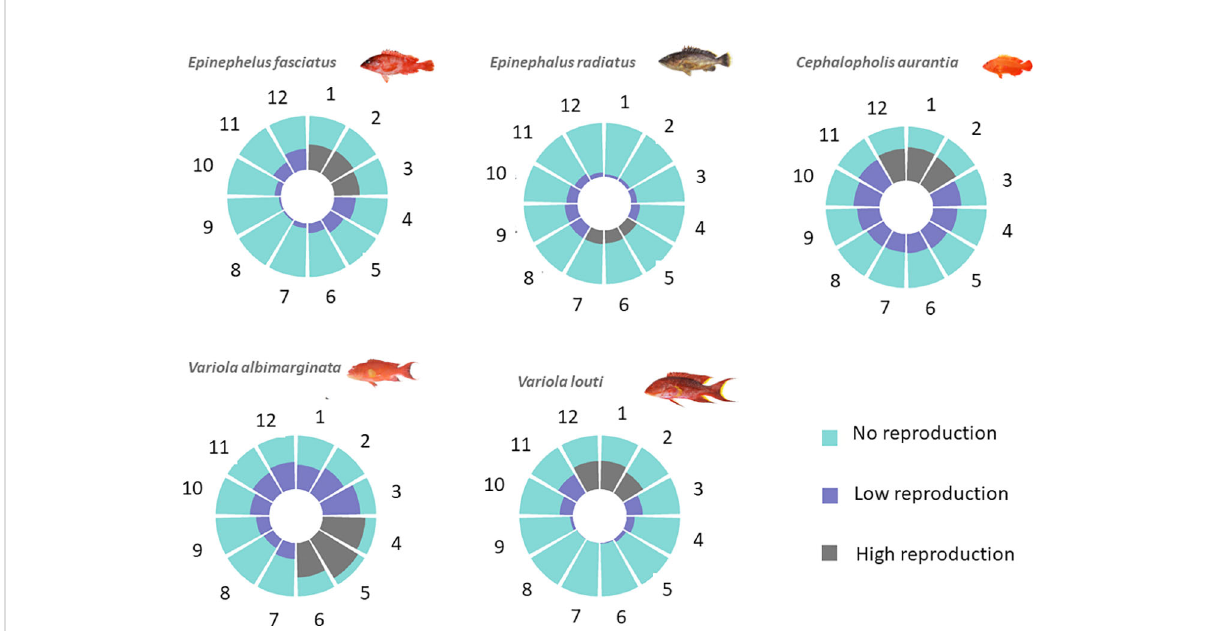
FIGURE 4 Reproduction period and intensity of grouper species around La Re ́ union Island. The reproduction intensity was quanti fi ed according to the monthly level of the gonadosomatic index (GSI) of the